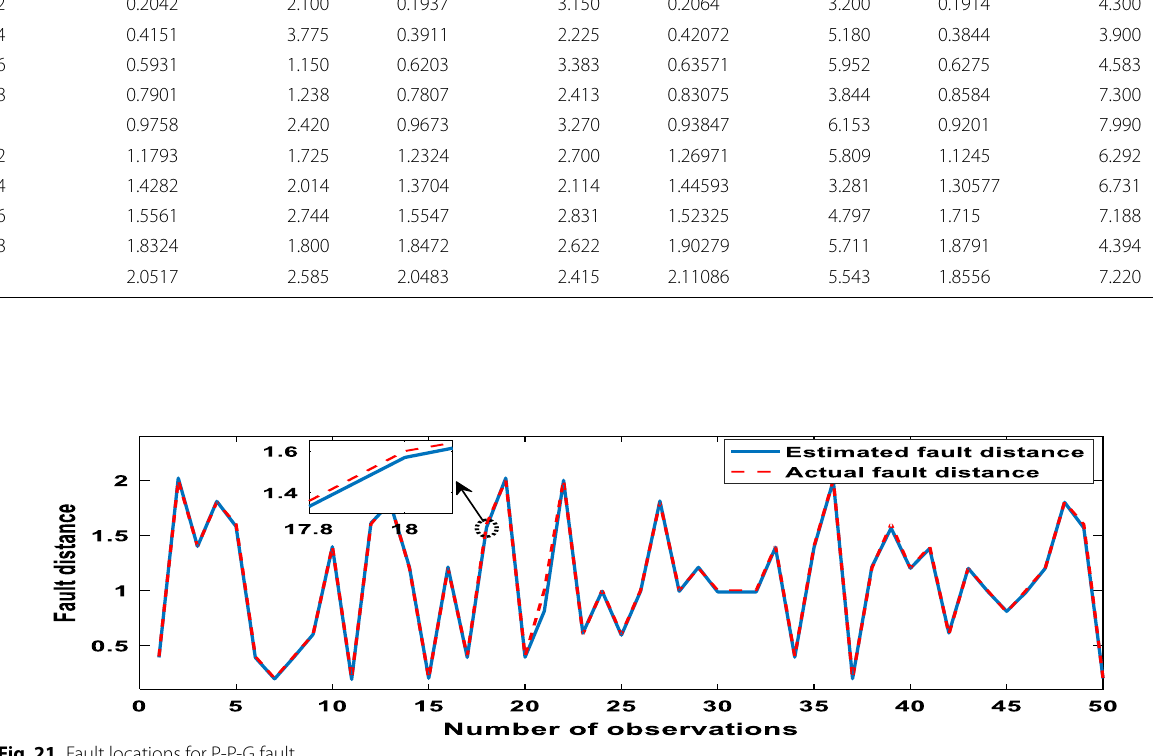
Fig. 21 Fault locations for P-P-G